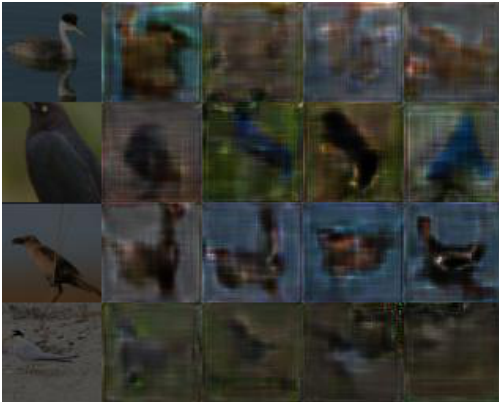
Fig. 4.1 Generated images using StackGAN.